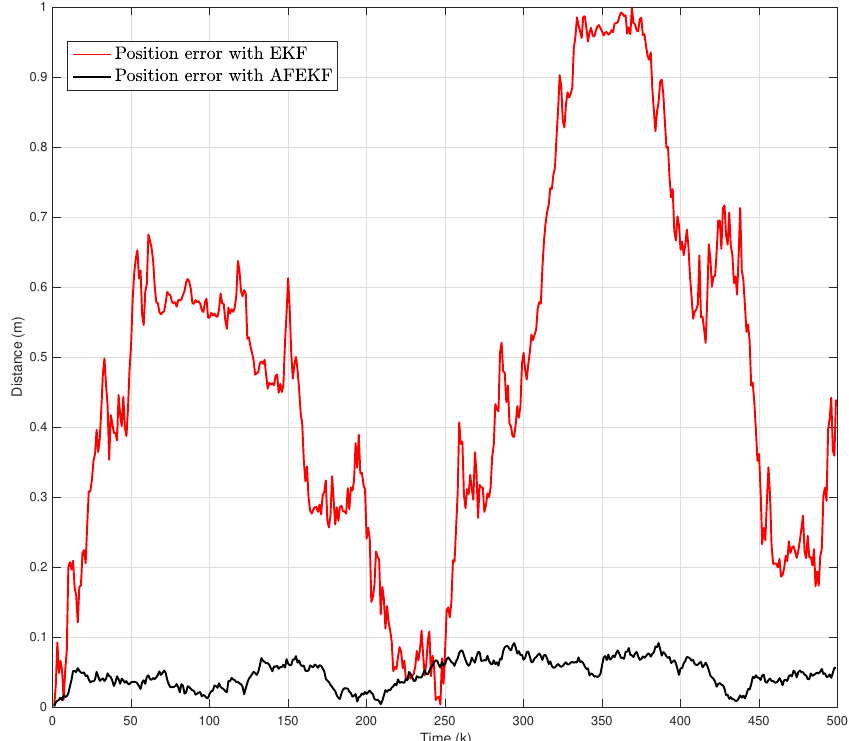
Figure 8. Robot’s position errors under stochastic